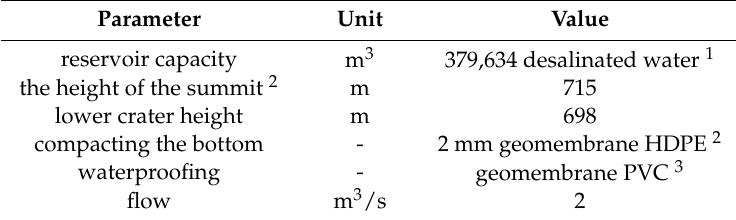
Figure 6. Sketch of the project implemented by the ABB (ASEA Brown Boveri) concern on the island of El Hierro with location of the wind–hydro power plant facilities (own elaboration). Signs: (1) La Caldera hydroelectric tank; (2) wind farm 5 × ENERCON; (3) pumping station; (4) hydroelectric station 4 × Pelton; (5) bottom tank; (6) pump station; (7) electrical substation with mutual connection between a wind farm, hydroelectric station and pump station; and (8) Llanos Blancos diesel power plant. Selected parameters of the upper reservoir of the hydroelectric power plant are listed in Table 2. Table 2. Structural and operational parameters of the upper hydropower plant [45].